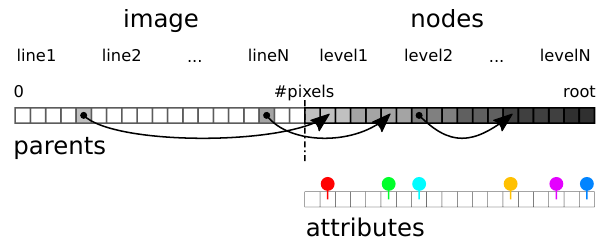
Figure 1. Hierarchical representation of image using a max-tree TRISKELE uses a compact representation of this data. The tree is defined only with an array of parents (see Figure 2). All pixels and nodes are associated with a unique index. The indexes un- der “pixel cardinality” refer to the pixels from the first row to the last row of the image. Indexes with higher “cardinality of pixels”, refer to tree nodes. Thanks to this building process, all nodes are sorted according to their level. So the light-gray nodes are on the right and the darker-gray ones are on the left.